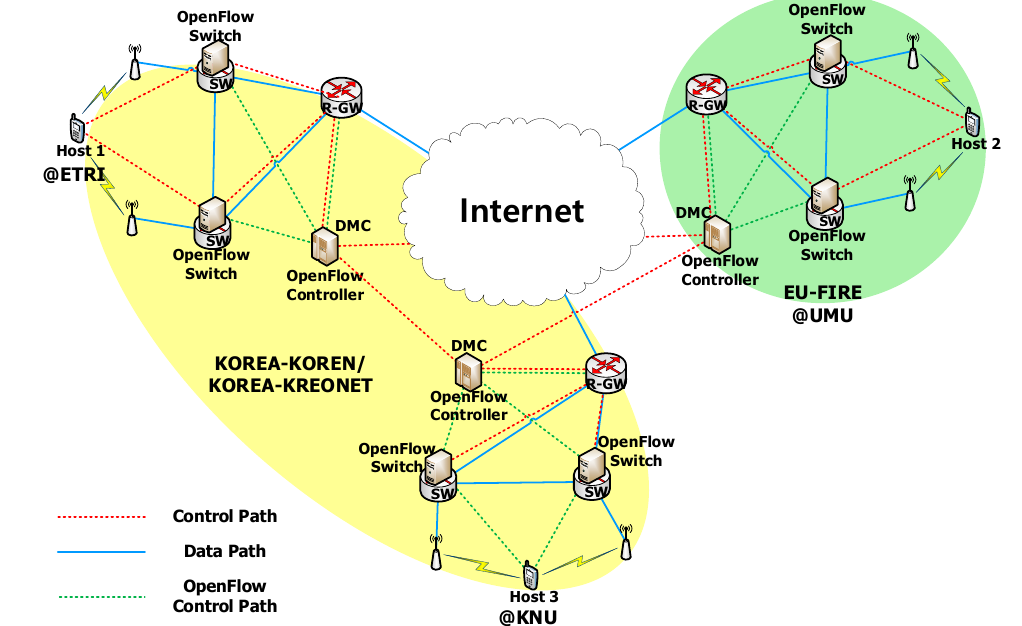
Figure 20. Testbed configuration for the MOFI evaluation.